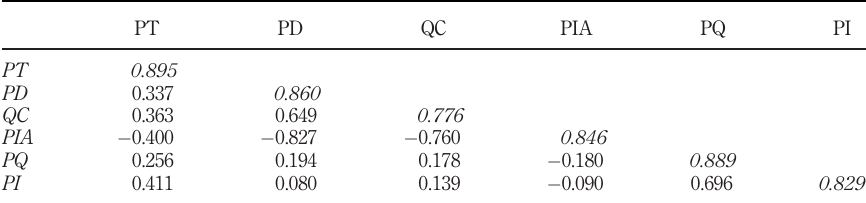
Table 2. Discriminant